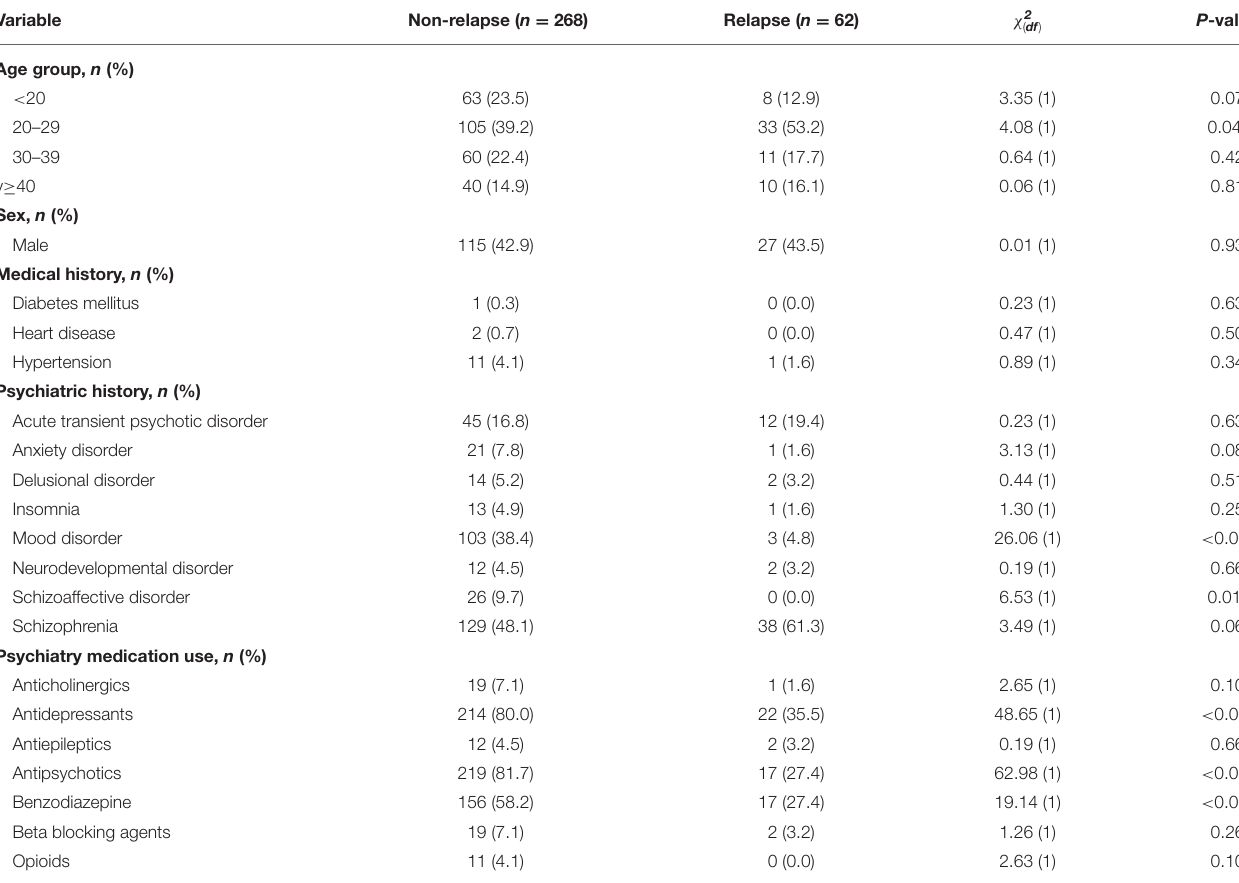
TABLE 1 | Baseline characteristics for study population with or without relapse.